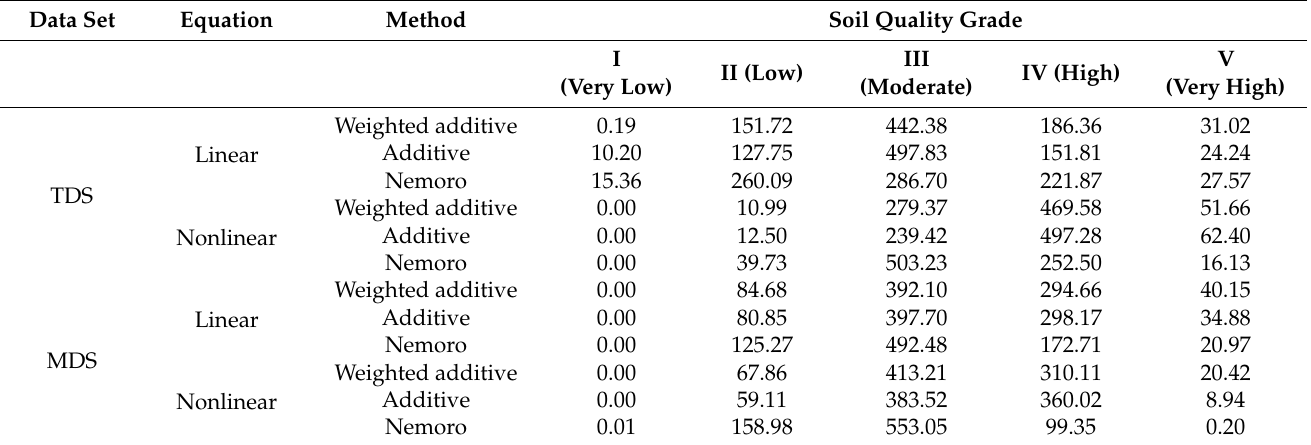
Table 6. Area, in km 2 , corresponding to each grade of soil